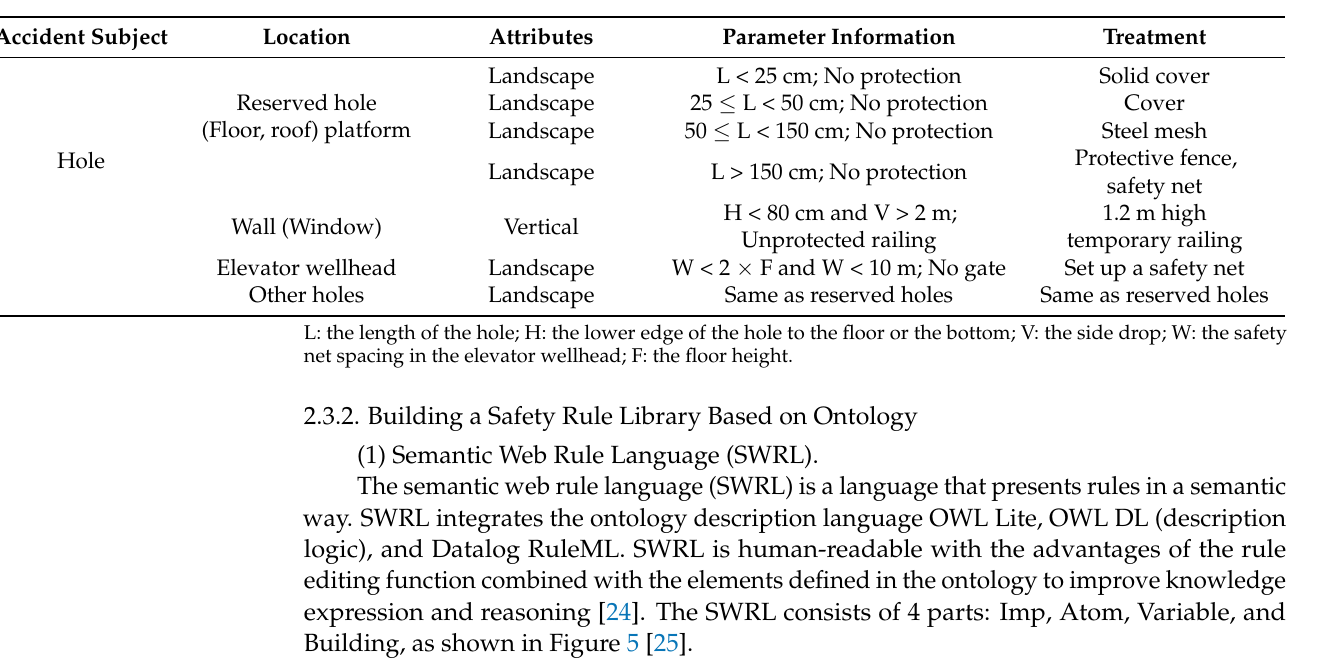
Table 8. Safety rule parameter establishment for a